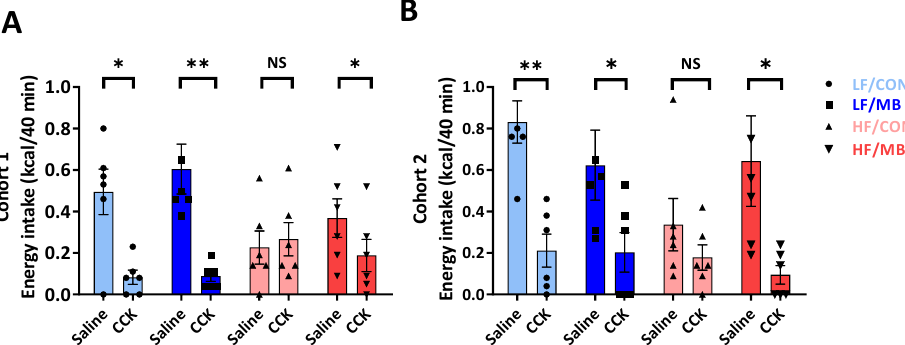
Figure 4. Effect of MB supplementation on vagally-mediated gut–brain signaling. Cholecystokinin (CCK) sensitivity in cohort 1 ( A ) and cohort 2 ( B ) of mice fed an LF or HF diet with or without 0.25% MB supplementation diet for 6 weeks. Paired Student’s t-test was used to determine statistical significance within groups. Values are means ± SEMs; n = 6/group/cohort. Asterisk (*) denotes significant differences among groups at * p < 0.05 and ** p < 0.01. NS, not significant; CCK, cholecystokinin; HF, high-fat; HF/CON, HF without MB; HF/MB, HF with 0.25% MB ( w / v ) in drinking water; LF, low-fat; LF/CON, LF without MB; LF/MB, LF with 0.25% MB ( w / v ) in drinking water; MB, monobutyrin.